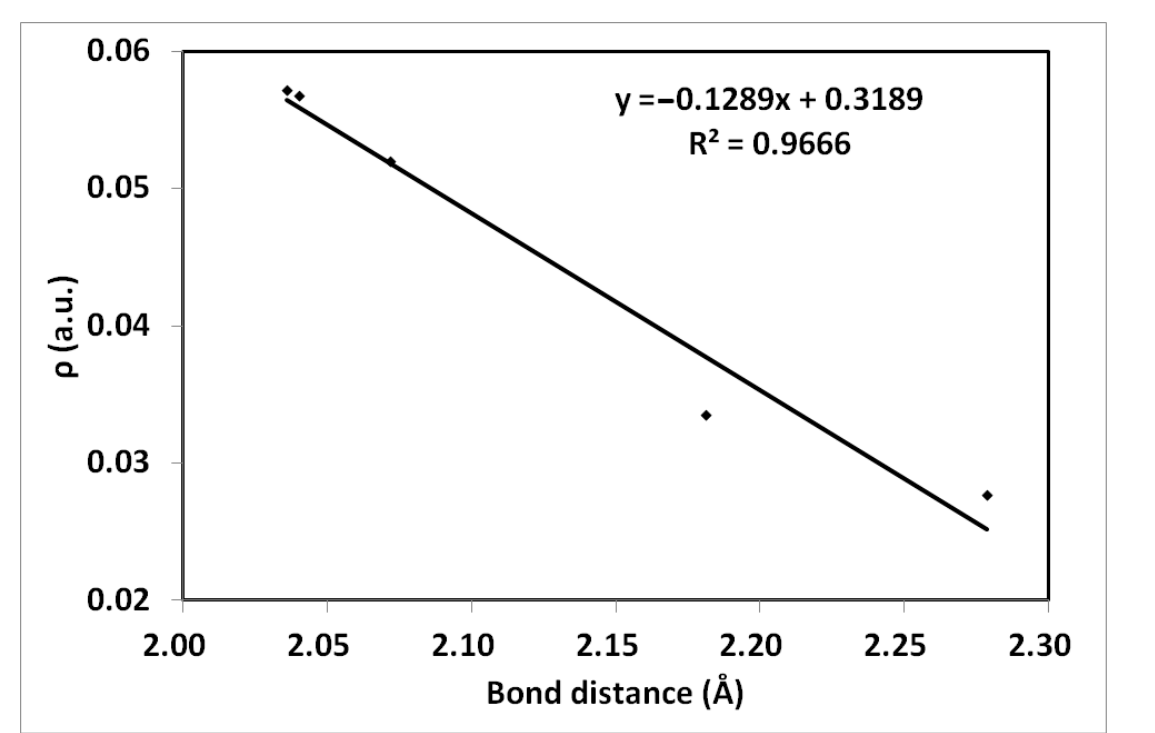
Figure 8. Correlation between the ρ and Zn–N bond distances.